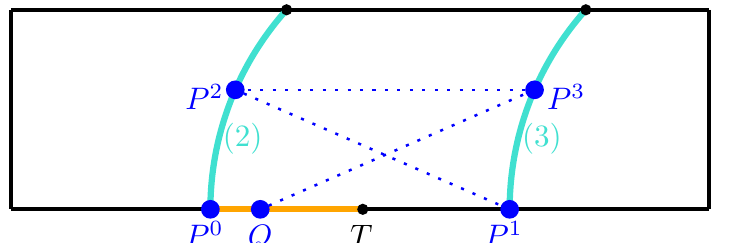
Figure 1: Wiggling through a rectangle from P 0 = ( p, 0) to Q = ( q, 0) in Lemma 3.1. The point Q must lie on the line segment P 0 T (orange), where T = ( p + 2(1 − point on P 0 T can be reached from some point on the circle arc (3), which is simply the circle arc (2) translated to the right by distance 1. Moreover, (2) is the circle arc with points at distance one from the point P 1 = ( p + 1 , 0). Hence, we can reach Q from P 0 via P 1 , some point P 2 on (2), and a point P 3 on (3). All dotted lines have unit